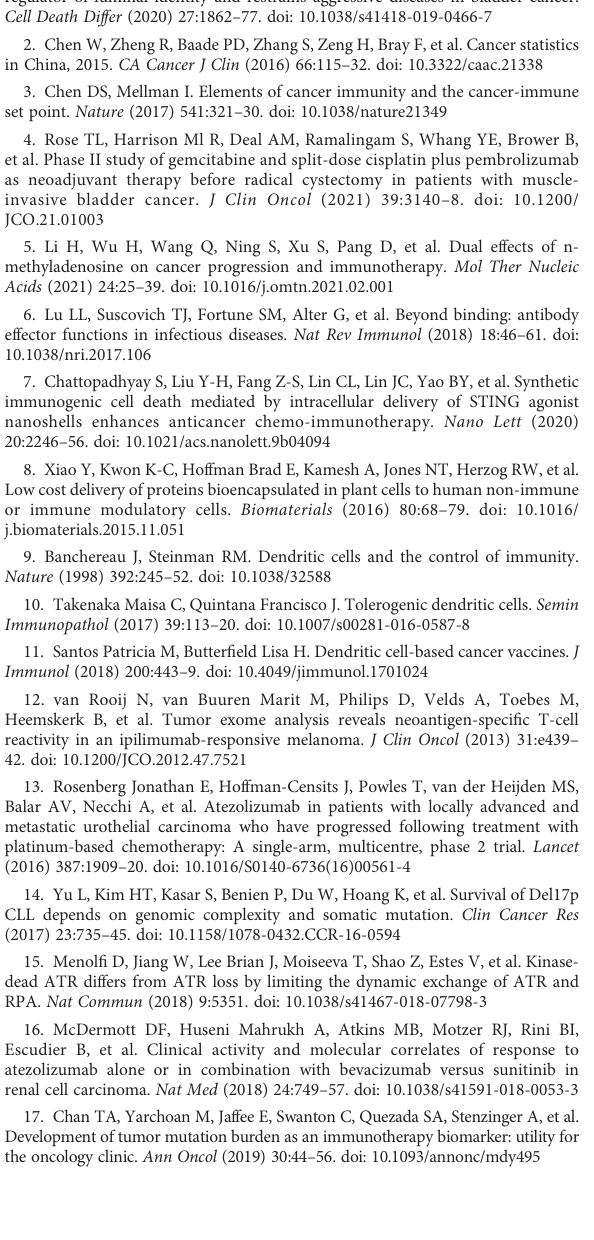
column represents a sample, and each column uses a different color and height to indicate the abundance ratio of immune cells in the sample. SUPPLEMENTARY FIGURE 2 Unsupervised clustering grouping in BLCA. (A – J) Unsupervised clustering algorithm in BLCA patients and consensus matrices for k = 2 –